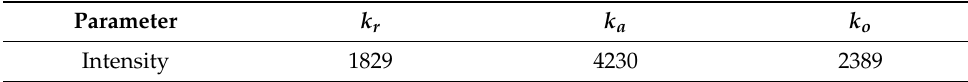
Figure 11. DE effecting with 30 individuals and 50 generations.